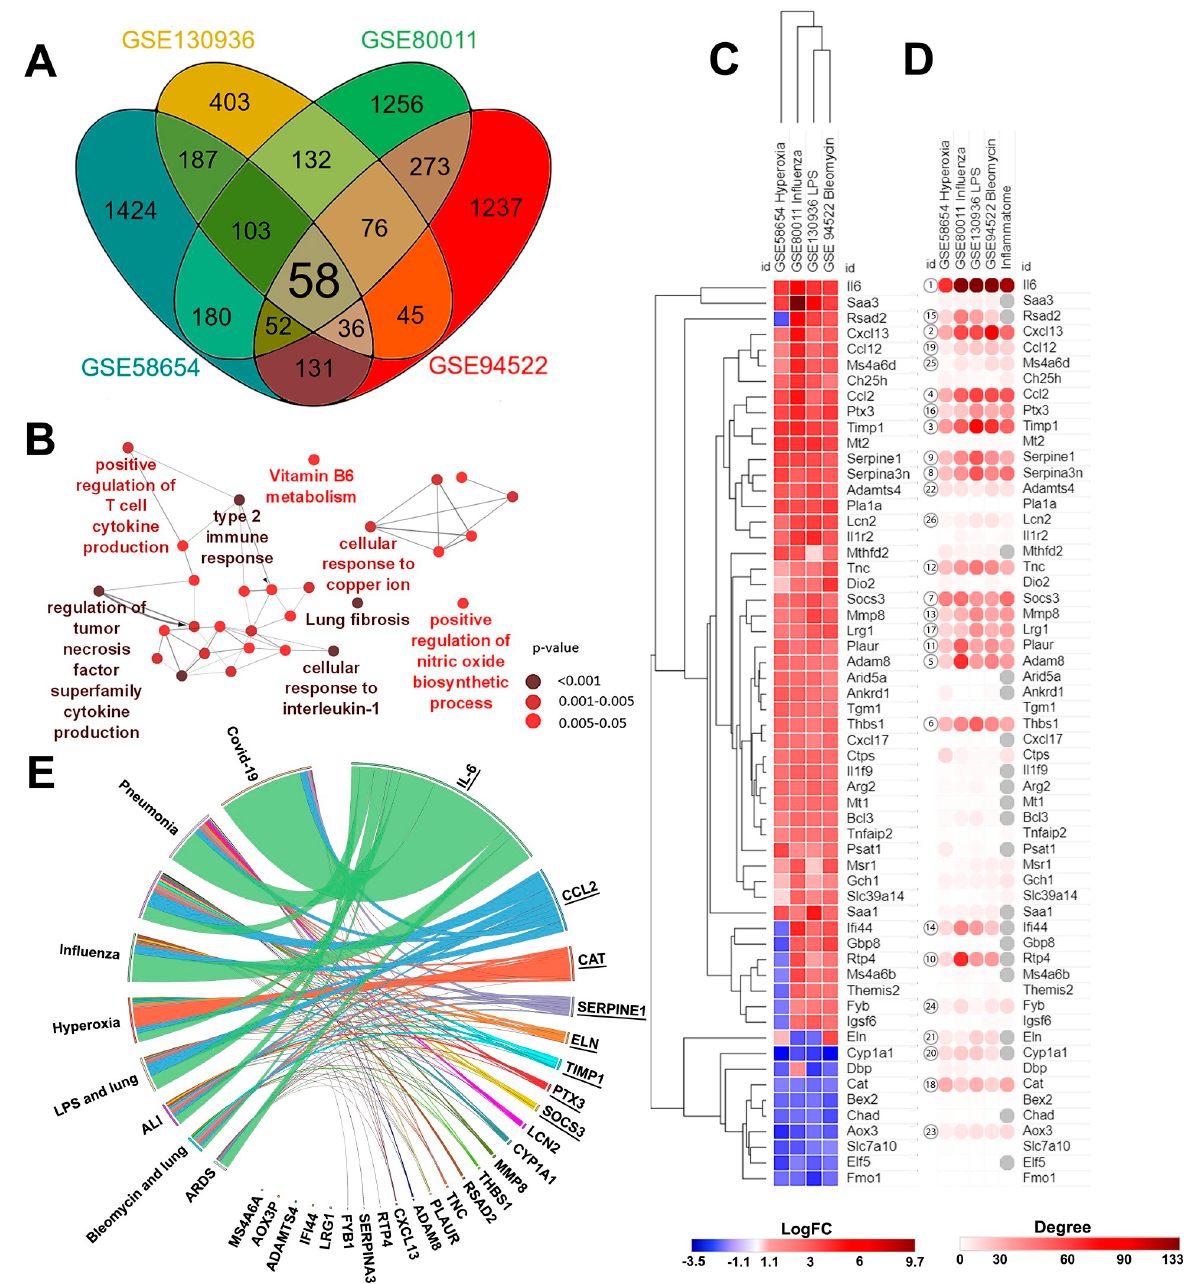
Fig 1. Key genes involved in the development of Acute Lung Injury (ALI): Results of bioinformatics analysis. ( A ) Venn diagram illustrating overlap between differentially expressed genes (DEGs) identified by the analysis of GSE80011, GSE130936, GSE58654, and GSE94522 datasets of ALI caused by different agents. ( B ) Functional analysis of overlapping DEGs identified in different GSEs. Enrichment for Gene Ontology (biological processes), KEGG, REACTOME, and Wikipathways terms were performed using the ClueGo plugin in Cytoscape. The labels of the most significant terms are shown. Colours of nodes represent the term enrichment significance. Only pathways with p < 0.05 after the Bonferroni step-down correction for multiple testing were included in the networks. ( C ) Heat map showing expression levels of DEGs in different GSEs. Heat map construction and hierarchical clustering (Euclidean distances) were performed using Morpheus. LogFC = Log 2 (fold change). ( D ) Heat map demonstrating the interconnection of DEGs in a protein-protein interaction network (PPI) reconstructed for each ALI dataset using the STRING database (confidence score � 0.7, maximal number of interactors = 0) in Cytoscape. Degree: number of interactions between a DEG and its partners. Inflammatome: number of interactions between DEGs and partners in the rodent inflammatome, constructed based on transcriptomic data published by Wang et al. [54]. ( E ) Co-occurrence of identified DEGs with relevant keywords in the scientific literature deposited in the MEDLINE database. Analysis was performed using the GenClip3 web service. Data were visualised via Circos.